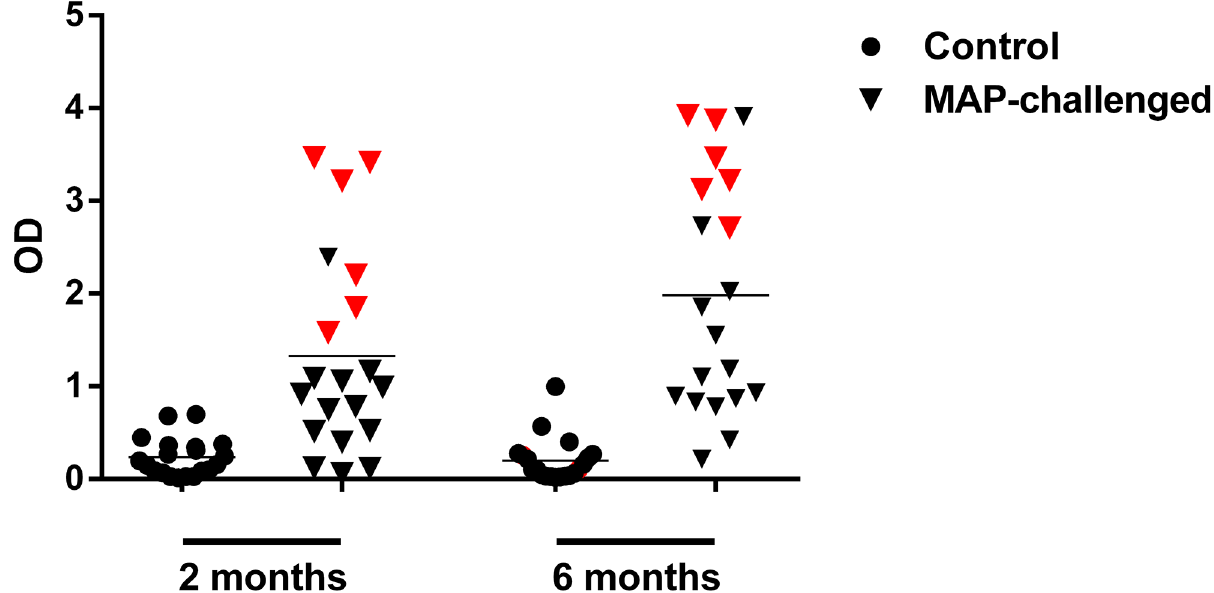
Fig 1. Responses to PPD-J in both sets of animals. IFN- γ production in control (n = 20) and MAP-challenged (n = 20) cattle at 2 months and 6 months post-infection in whole blood in response to PPD-J. Each point represents an individual animal while the red points indicate the six MAP-challenged cattle selected for miRNA-sequencing. The horizontal lines represent mean OD 450 values for each